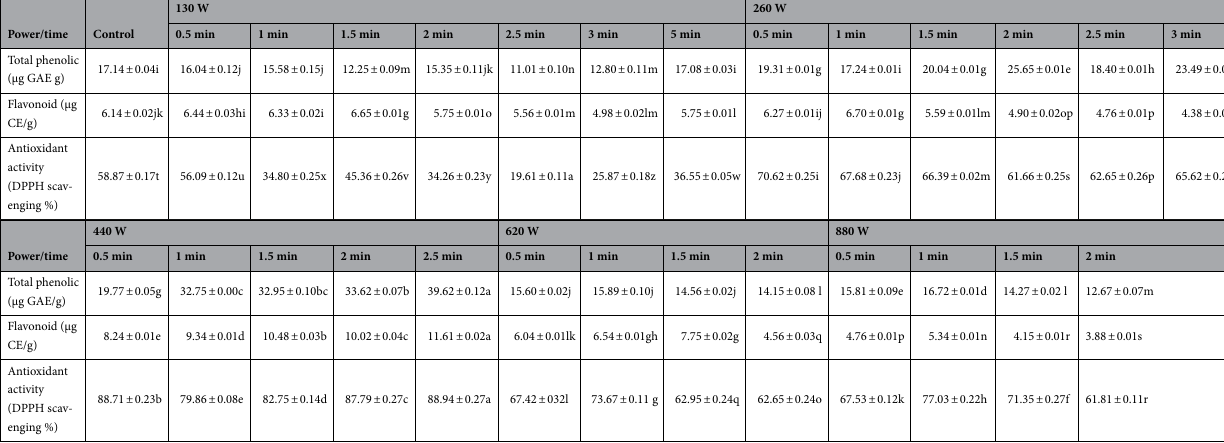
Table 1. Total phenolic, flavonoid, and antioxidant activity of rice bran treated in microwave oven. Rice bran was burnt partially (treatment in 260 W for 5 min, 440 W for 3 and 5 min as well as 620 W and 880 W for 2.5, 3, 5 min). Values are means ± standard deviations ( n =